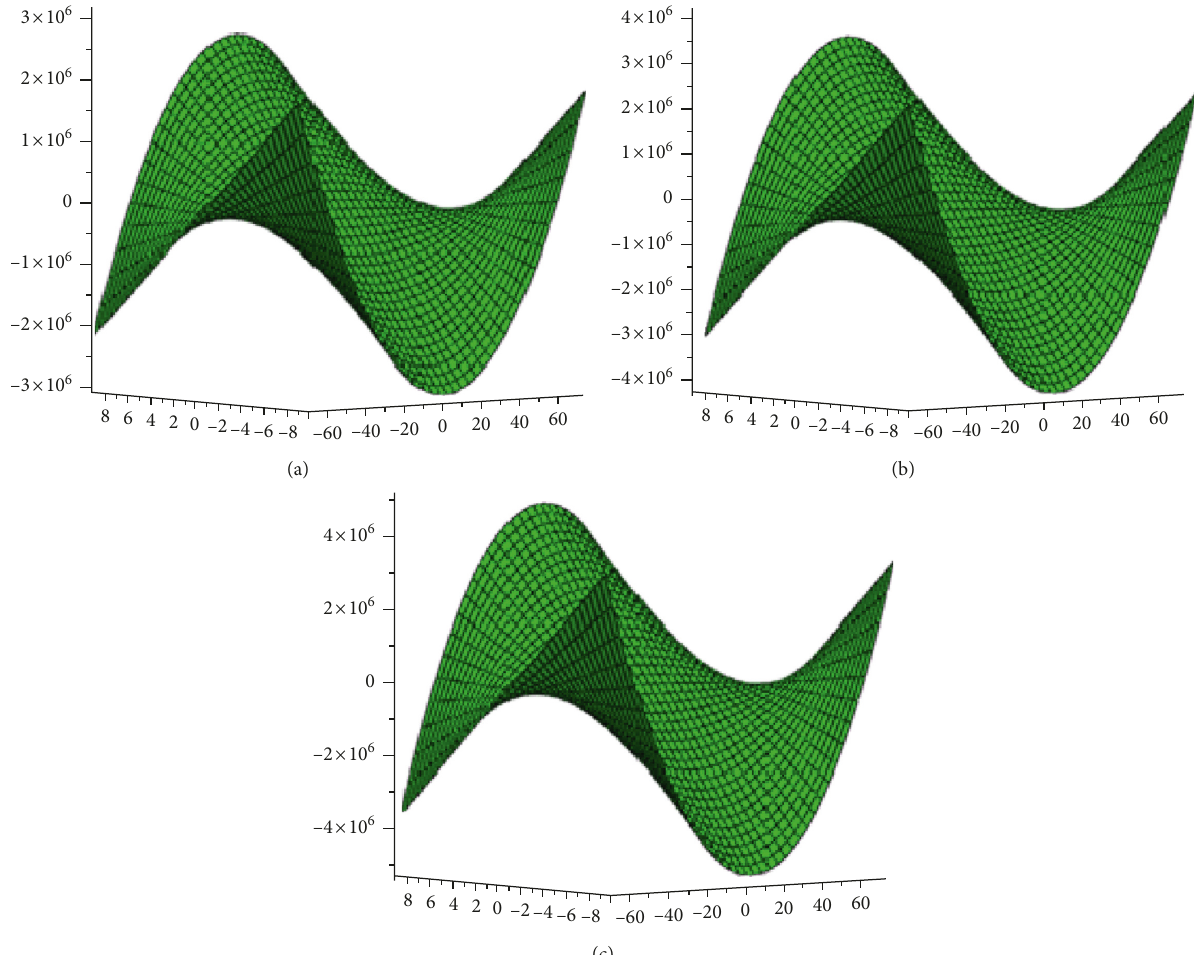
Figure 14: Rock beam internal stress distribution at different time. (a) 0h. (b) 24h. (c)